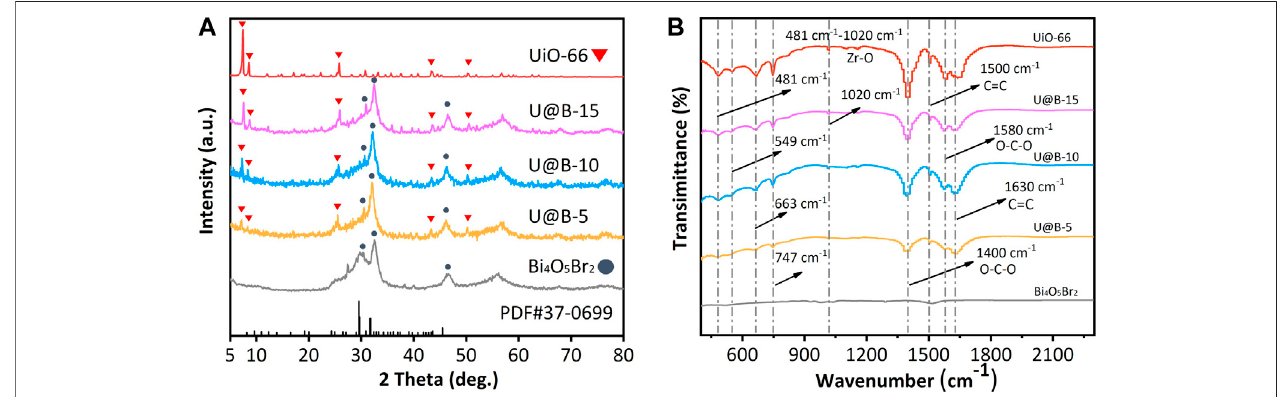
FIGURE 1 | (A) XRD patterns of UiO-66, Bi 4 O 5 Br 2 and U@B-X, (B) FTIR spectra of UiO-66, Bi 4 O 5 Br 2 , and